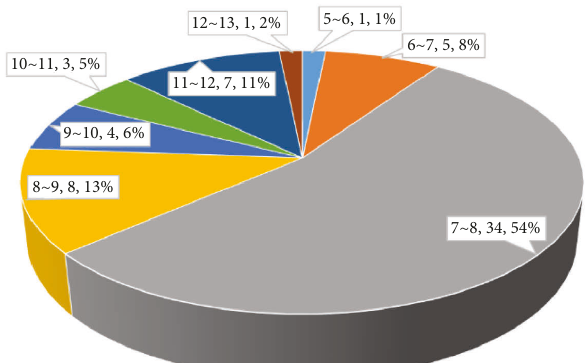
Figure 4: Water sample pH value statistics (pH value, number of groups, and